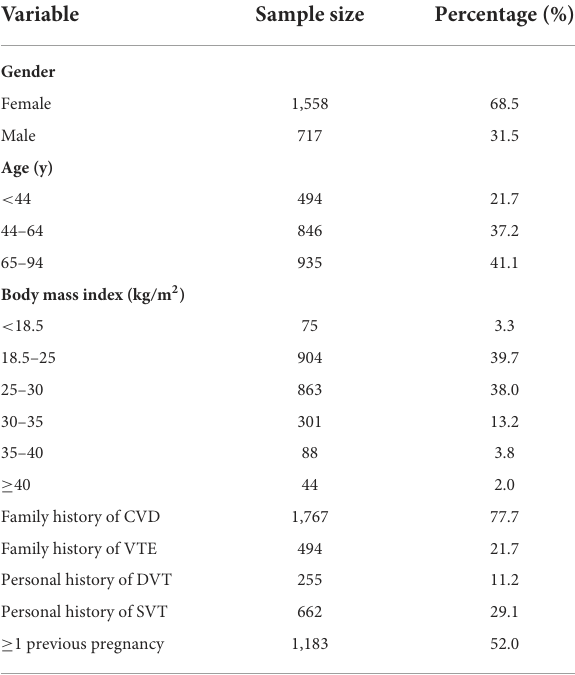
TABLE 1 Demographic characteristics of the study